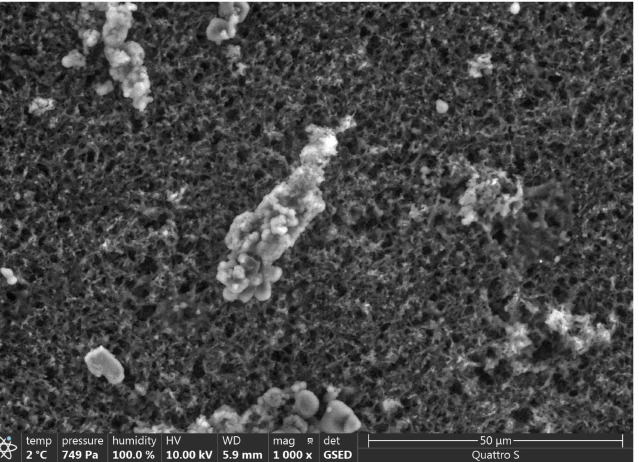
Figure 4. Illustration showing the magnification of Product K (1000 × ). A particle of >50 µ m was observed.